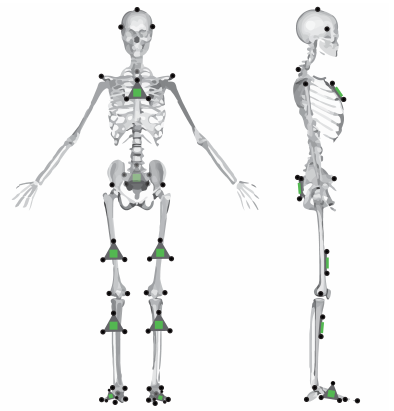
Figure 1. Placement of the reflective markers (black circles) and IMUs (green) on the subject. IMUs on the thigh and shank were not placed precisely, and location varied in the transverse